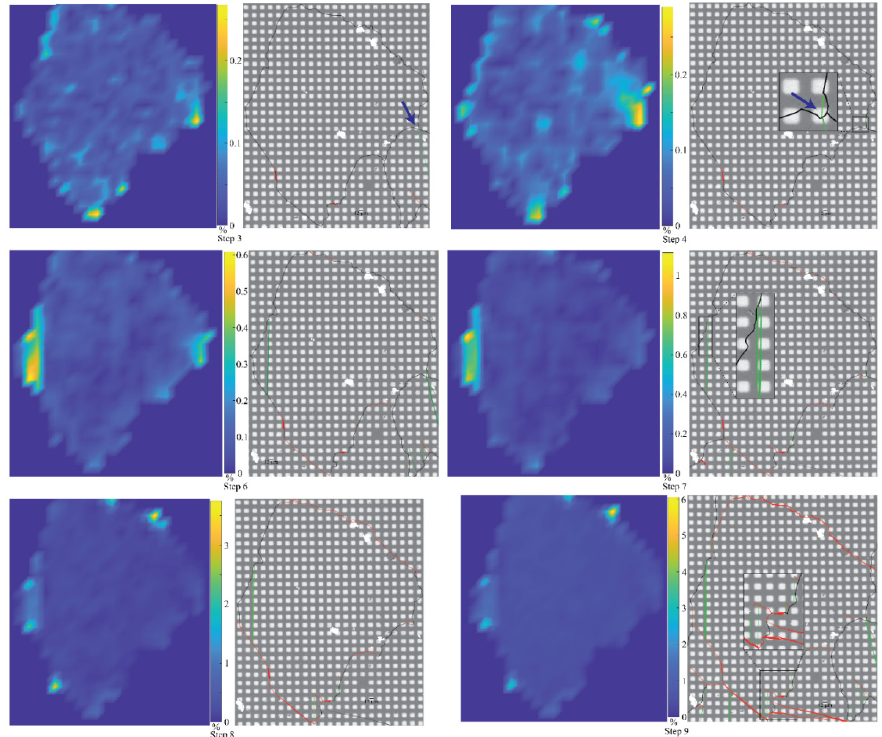
Figure 13. Equivalent Von Mises deformation map of crystal 6 at different steps of sample deformation. The black lines represent the grain boundaries. The green lines show the twinned planes. The red lines show the fracture zones. The blue arrow points to the tiny twin planned that appeared step 4 due to the strain concentration of an adjacent twinned plane.